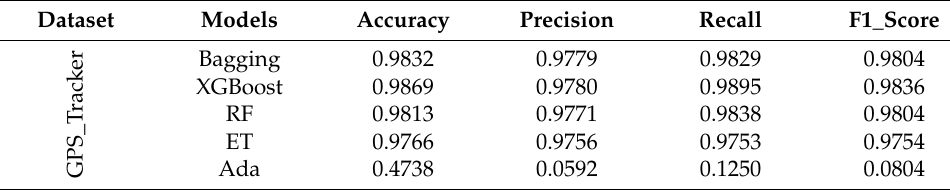
Table 6. The classification report for the IIoT GPS_Tracker dataset.